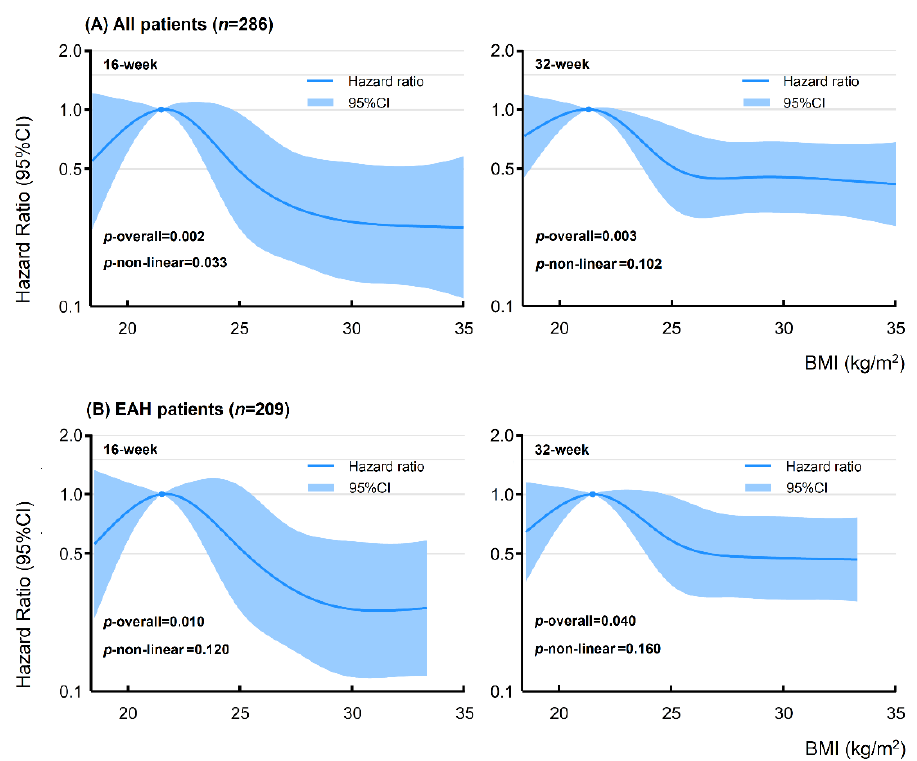
Figure 3. Non-linear analysis between BMI and cumulative CR rate at the 16th and 32nd week of treatment for all patients and the subgroup of patients with EAH. Non-linear analysis was modeled by restricted cubic spline. The HR and 95%CI were evaluated by Cox regression analysis adjusted by age at diagnosis, histology, and progestin therapy. BMI, body mass index; EAH, endometrial atypical hyperplasia; CR, complete response; CI, confidence interval; HR, hazard ratio.